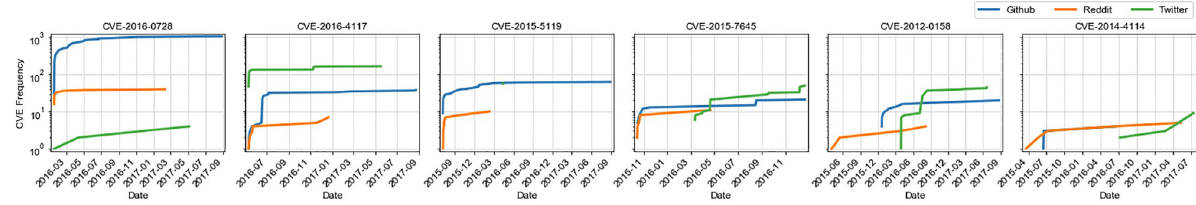
Fig 8. Vulnerability discussion spread across social platforms for CVEs exploited by Russian APT groups (APT27 and APT 29).